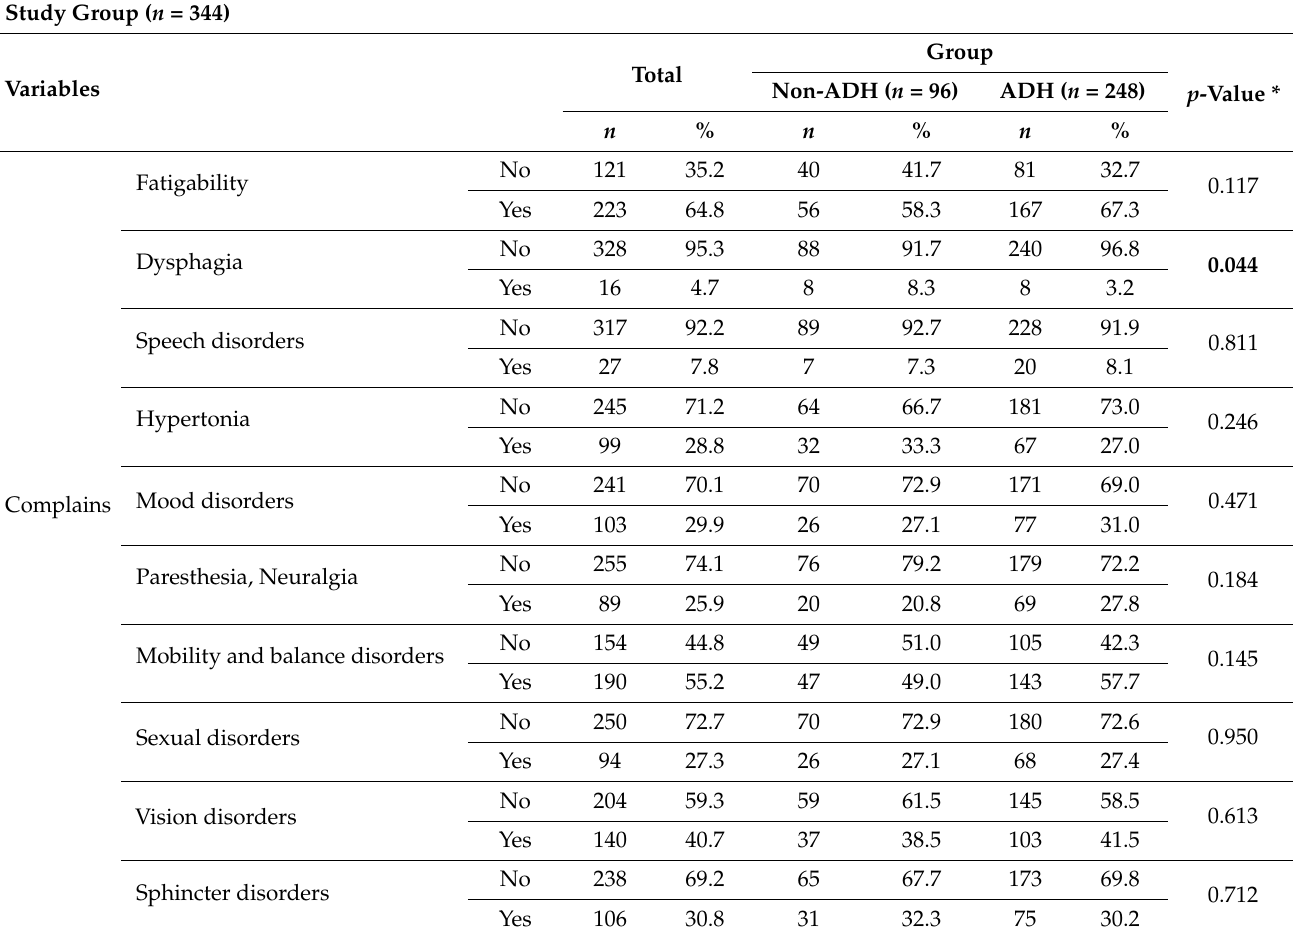
Table 3. Comparison of the incidence of symptoms in adherent and non-adherent